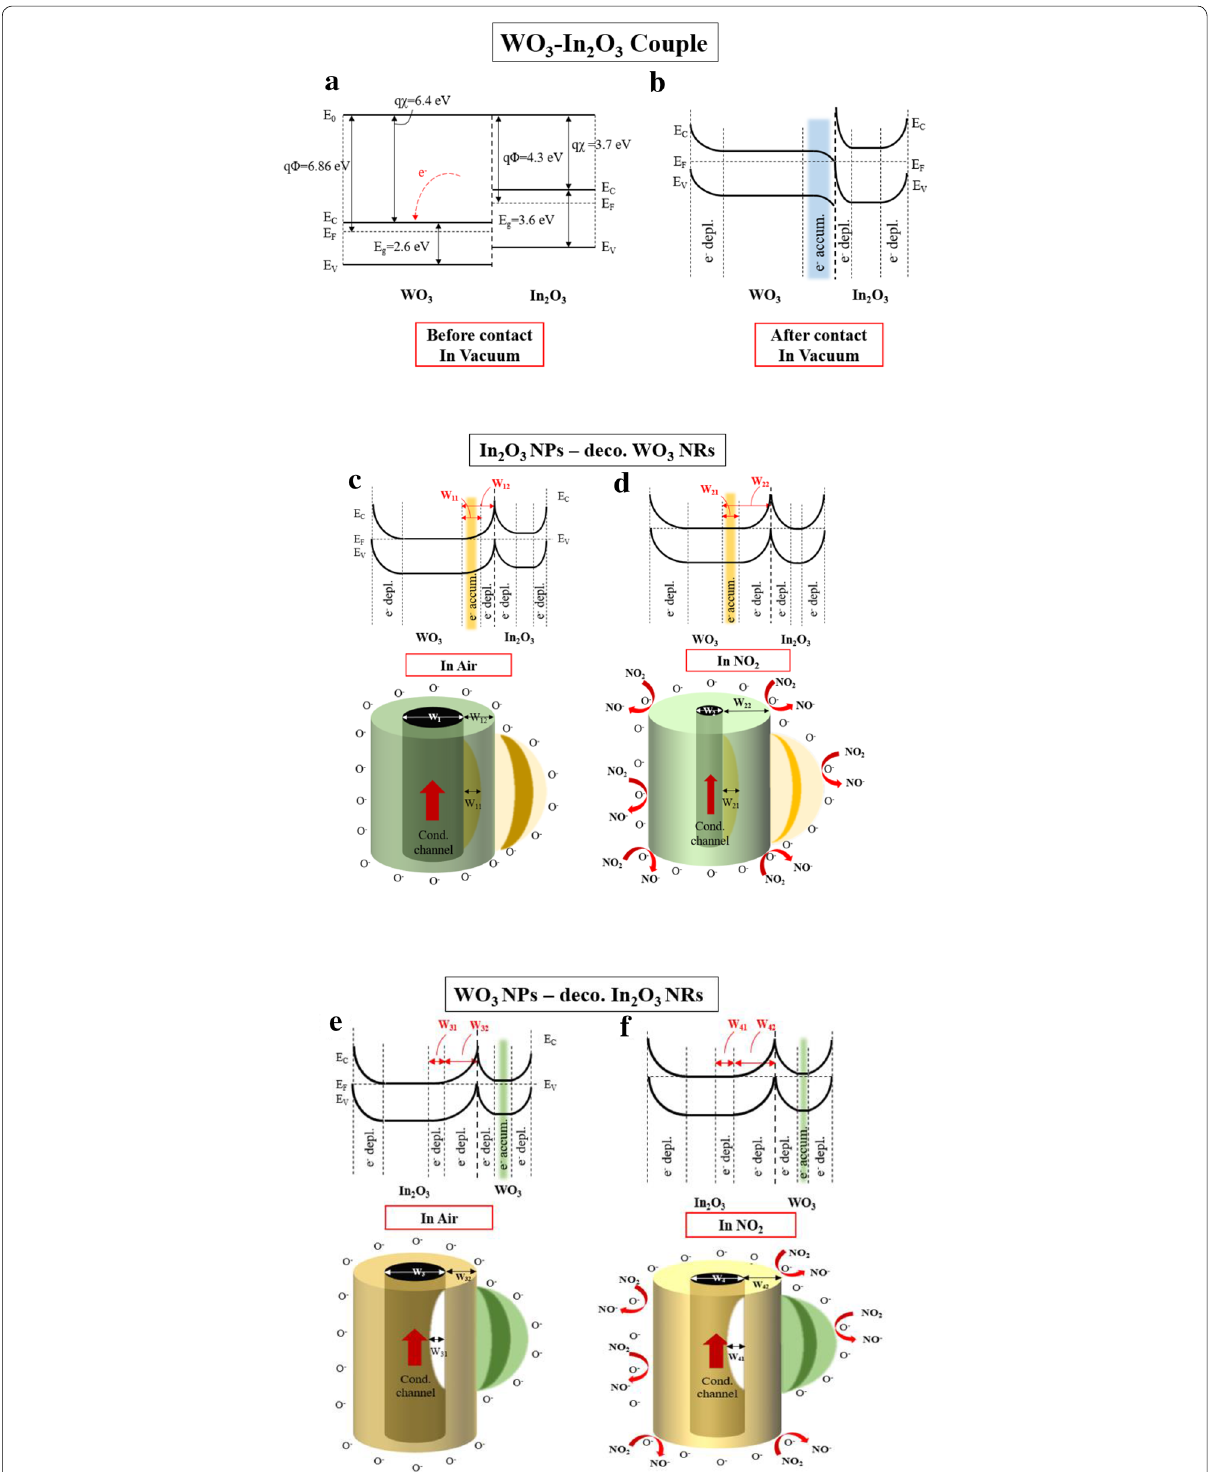
Fig. 9 Energy band diagrams of a WO 3 ‑In 2 O 3 couple a before and b after contact. Energy band diagrams and schematics of In 2 O 3 NPs‑decorated WO 3 NRs: c in air and d in NO 2 , and of WO 3 NPs‑decorated In 2 O 3 NRs: e in air and f in NO